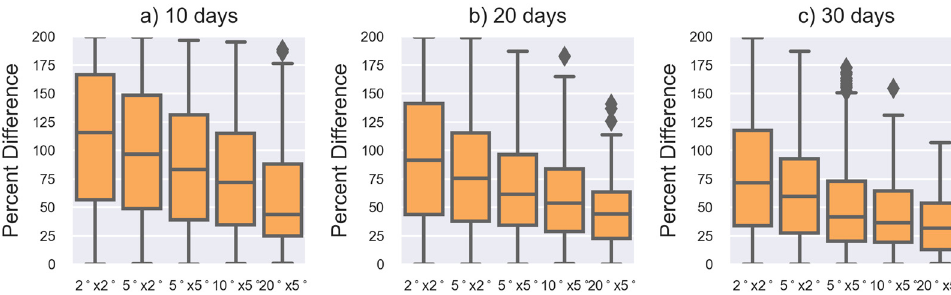
Figure 4. As in Figure 3, but with (cid:1842)(cid:1830) for 10 ( a ), 20 ( b ), and 30 ( c ) day time periods. Fliers (measurements beyond the whisker range) are